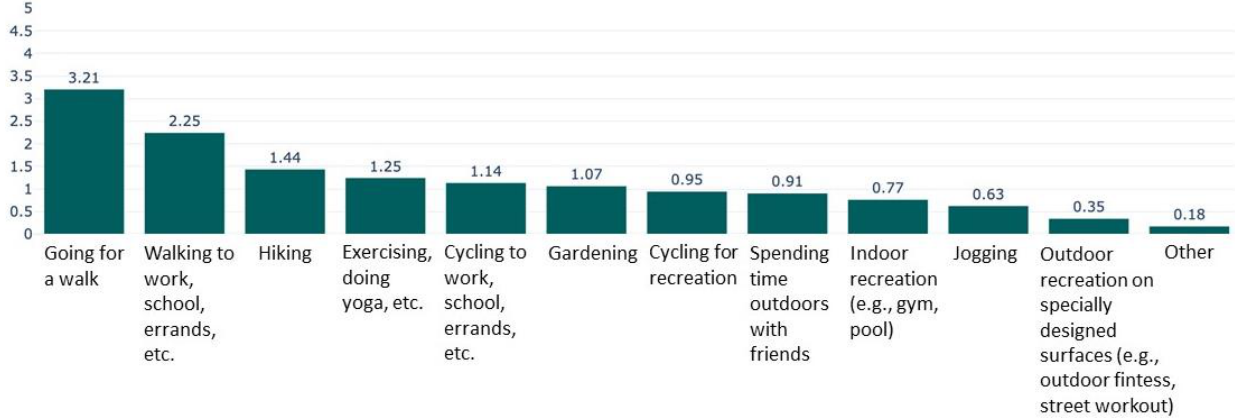
Note: Missing values are excluded from the